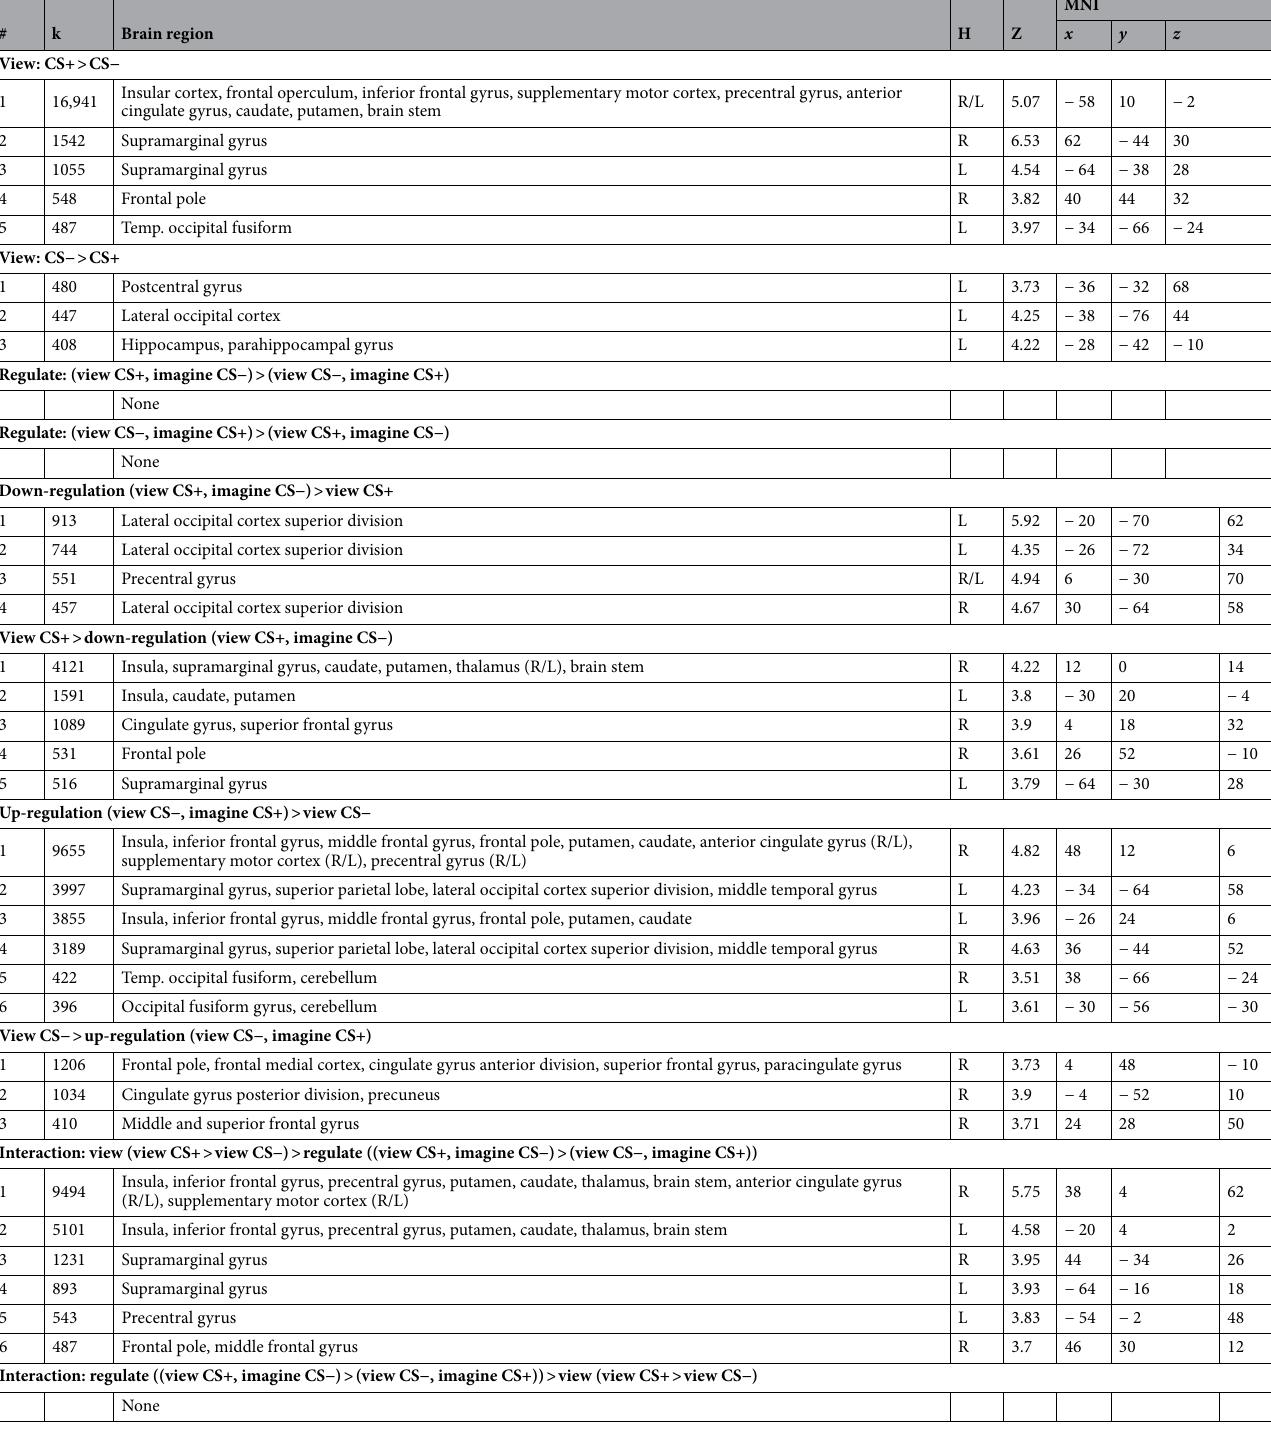
Table 4. Experiment 2 (Visit 2)—regulation of fear conditioning via mental imagery. # = the number of a cluster, ordered by size; k = the number of contiguous voxels in the cluster; Brain region = the region of local maxima included in the broader cluster. The region names are taken from the Harvard–Oxford atlas in FSL; H = principal hemisphere of the cluster, right (R) or left (L); Z = maximum z-value from the cluster within the given brain region; # = number of voxels from the cluster inside the given brain region. Regions with less than 5 voxels in the cluster are not reported, except if it is the only cortical region identified in the cluster; MNI(X,Y,Z) = coordinates of the voxel with the maximum effect in the standardized space of the Montreal Neurological Institute (MNI), represented in units of millimeters (mm). All whole-brain unthresholded group- level maps can be viewed at neurovault.org (see